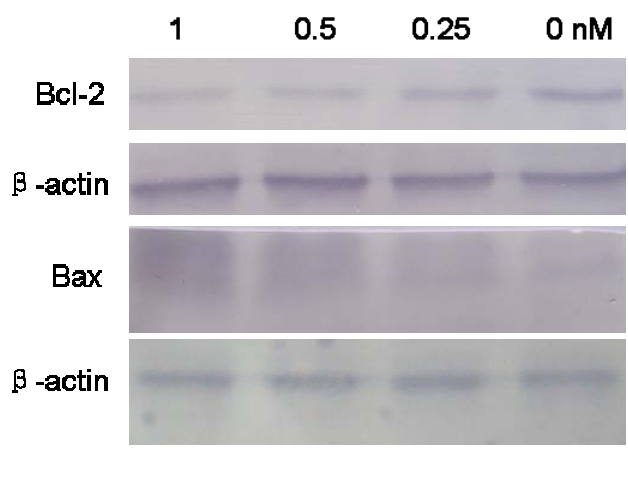
Figure 7. Effect of B2 on the expression of Bcl-2 and Bax. SMMC-7721 cells were treated with desired concentration of B2 for 48 h. Anti-apoptotic Bcl-2 and pro-apoptotic Bax were analyzed by western blot; β -actin was used as a control for